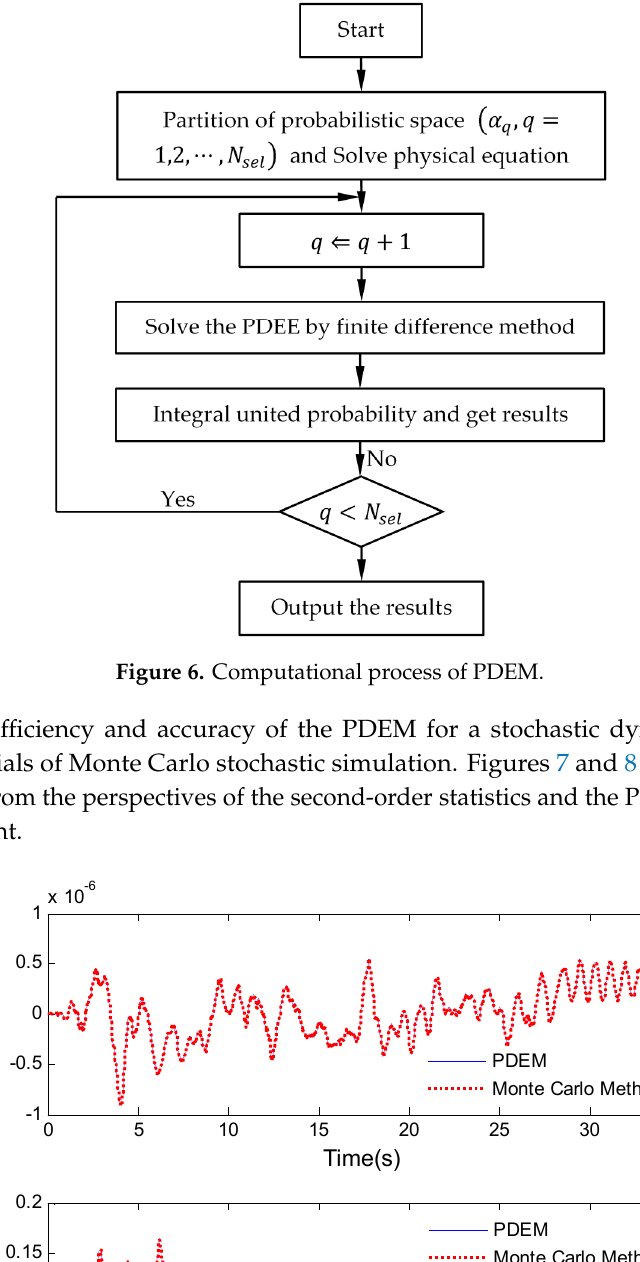
10 of 16 Figure 5. Finite-element (FE) model of laterally loaded pile. Table 2. Parametric properties of the constitutive. Concrete01